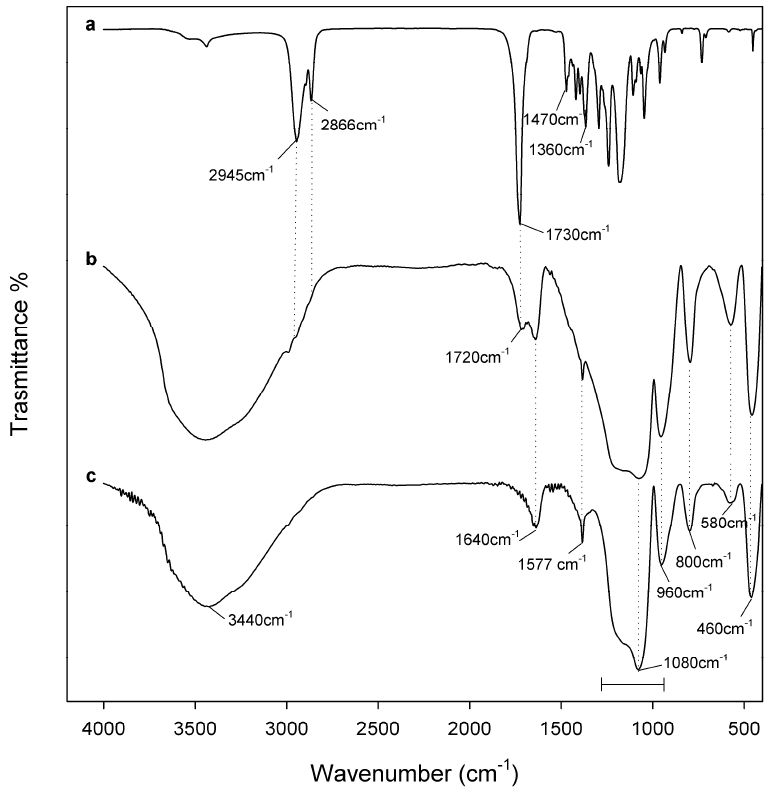
Figure 2. FT-IR spectra of ( a ) PCL, ( b ) SiO 2 + PCL 6 wt.% gel and ( c ) SiO 2 gel.